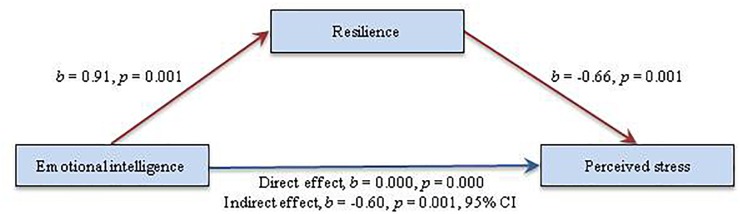
Standardized Solution of the Final Model in the American Sample.